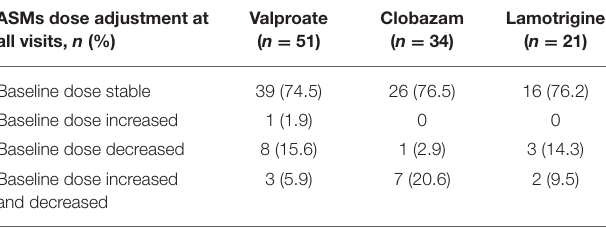
Valproate Clobazam Lamotrigine ( n = 51) ( n = 34) ( n = 21)